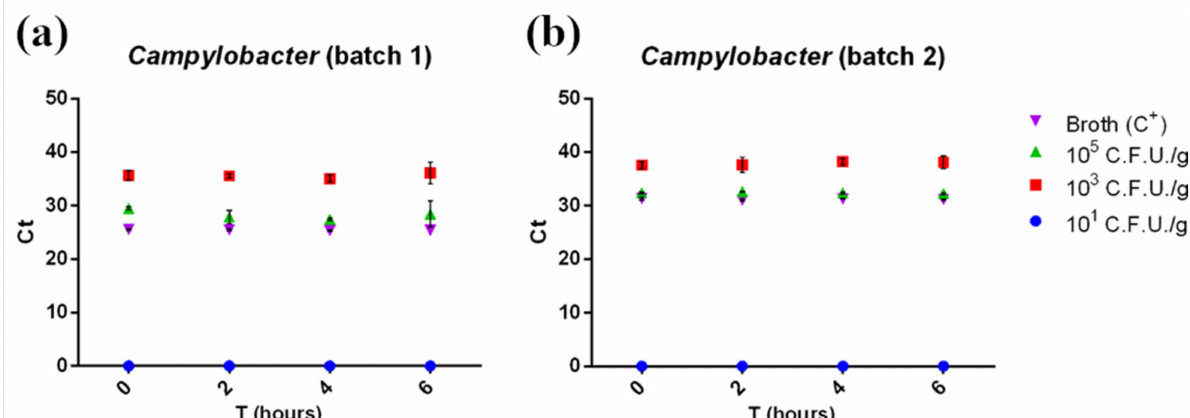
Figure 5. Ct of the first batch ( a ) and the second batch ( b ) of minced chicken meat contaminated with Campylobacter spp. plotted against enrichment times (0, 2, 4, and 6 h). Ct was inversely correlated with the starting contamination level, but not with enrichment time, highlighting the slow-growing rate of the pathogen. No amplification was detected in 10 1 CFU/g contaminated samples. Measurements were performed on two separate batches of minced chicken meat in triplicate. The mean ± SD of each measurement is shown. The full dataset can be found in Table S3b.